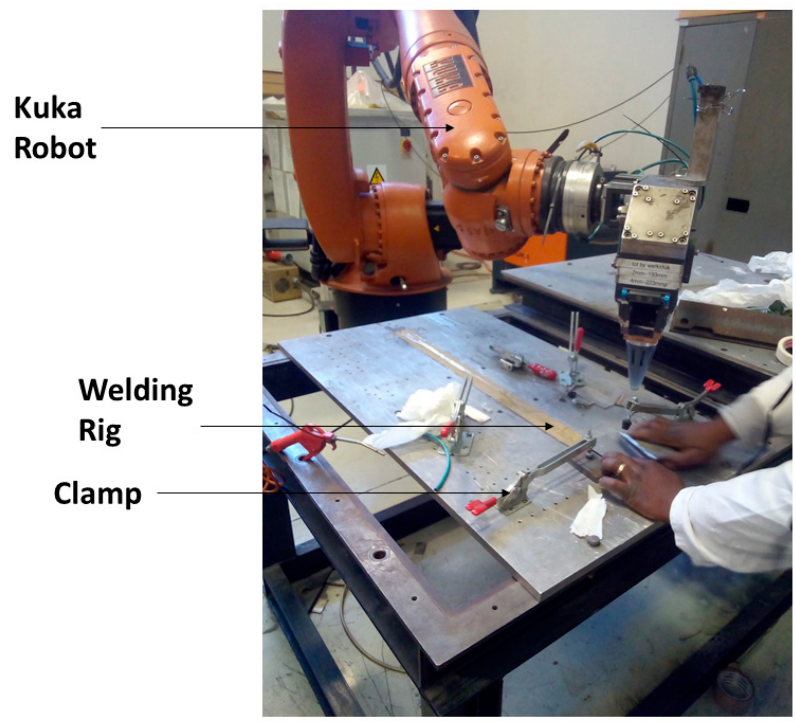
Figure 1. Experimental setup. Microhardness profiles were determined using the Indentec Digital Vickers micro- hardness tester (Zwick Roell Indentec, West Midlands, UK) at 4.9 N and dwell time of 15 s, ASTM E384 [12]. The tensile strength was determined using the UTM Zwick Roell 2250 (Zwick Roell, West Midlands, UK) and following ASTM E8